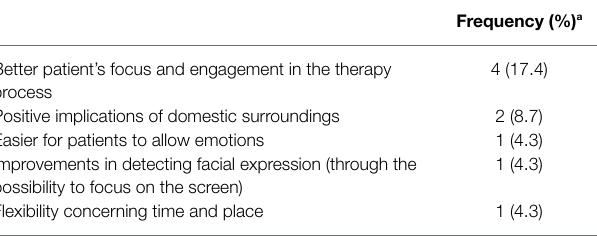
TABLE 6 | Frequencies of perceived improvements in eEMDR sessions compared to face-to-face EMDR sessions.